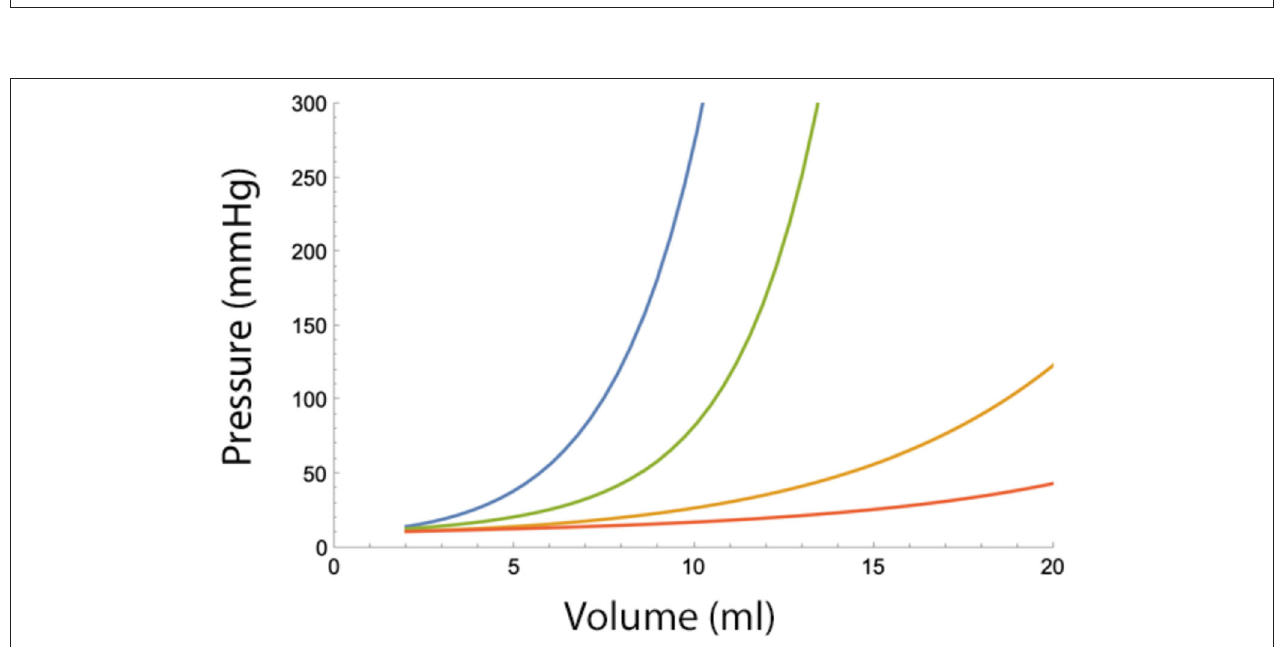
10ml, Pbaseline 10 mmHg. = =